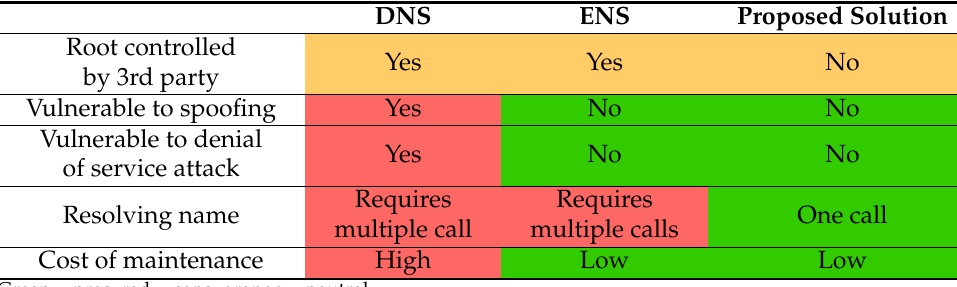
Table 2. Comparison between mentioned name services. DNS ENS Proposed Solution Root controlled Yes Yes No by 3rd party Vulnerable to spoofing Yes No No Vulnerable to denial Yes No No of service attack Requires Requires Resolving name One call multiple call multiple calls Cost of maintenance High Low Low Green = pros, red = cons, orange =